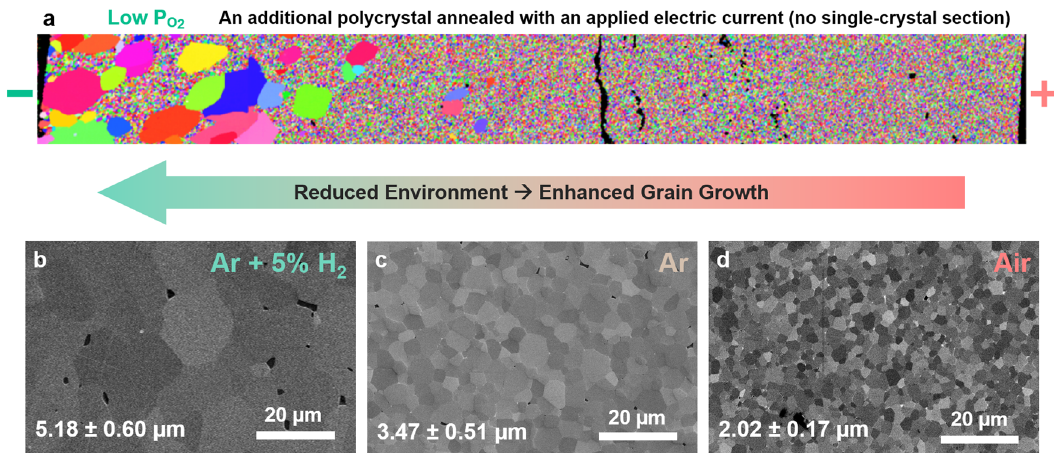
Fig. 4 Enhanced grain growth in reduced environments for ZnO + 0.5 mol% Bi 2 O 3 polycrystalline specimens. a EBSD map of a ZnO + 0.5 mol% Bi 2 O 3 polycrystalline specimen (without a single-crystal section) annealed with an applied current, showing similar abnormal grain growth in the reduced region near the cathode (negative electrode). Cross-sectional SEM micrographs of polycrystalline specimens quenched from 880 °C after annealing for 4 h in b Ar + 5% H 2 c Ar, and d air. Additional low-magni fi cation images are shown in Supplementary Fig. 19. These observations further support that the oxygen reduction caused enhanced grain